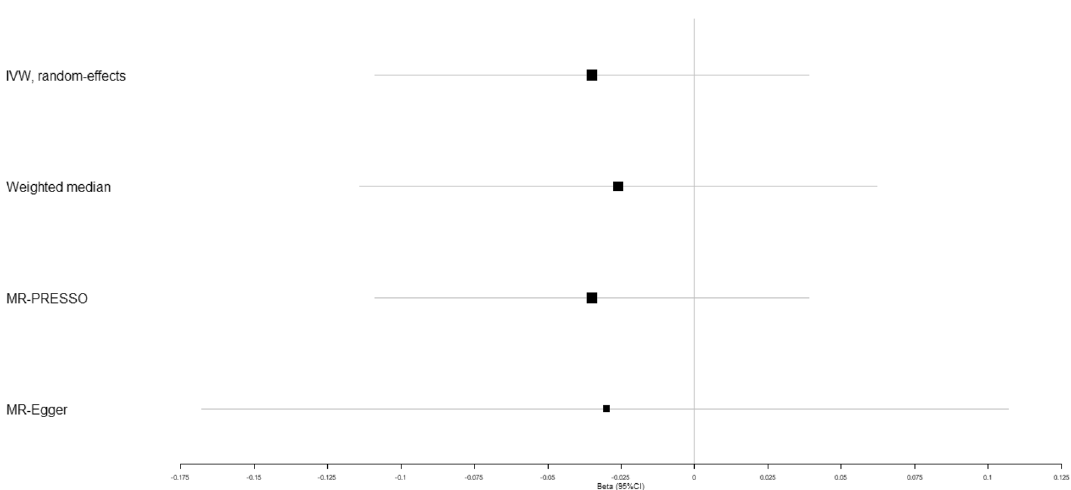
Figure 6. Beta (95% CIs) for causal influence of circulating adiponectin on intracerebral hemorrhage through multiple